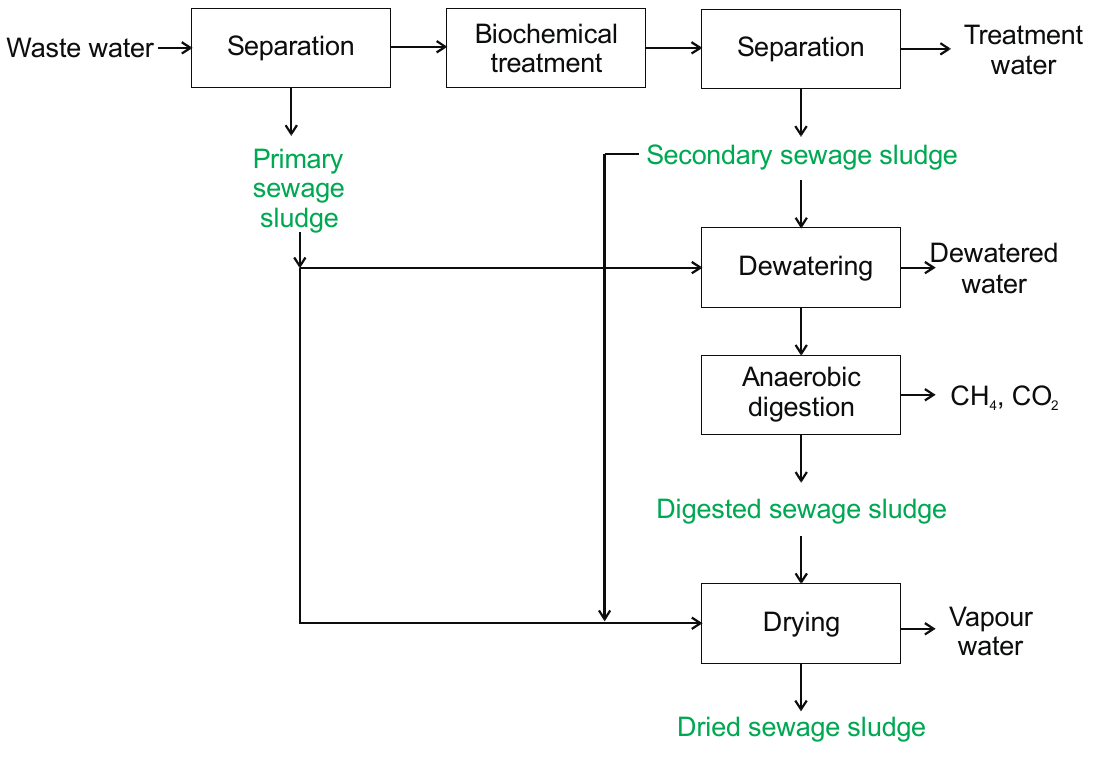
Figure 2. Various types of sewage sludge.